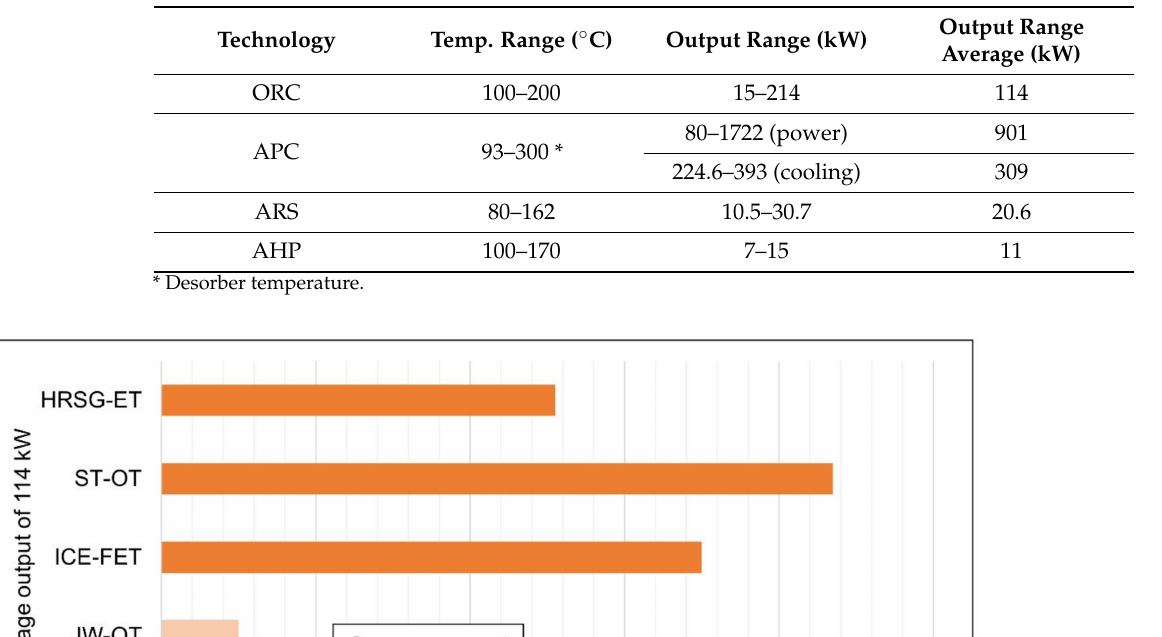
Table 13. Feeding temperature ranges and capacity ranges for the selected CHP heat recovery technologies.